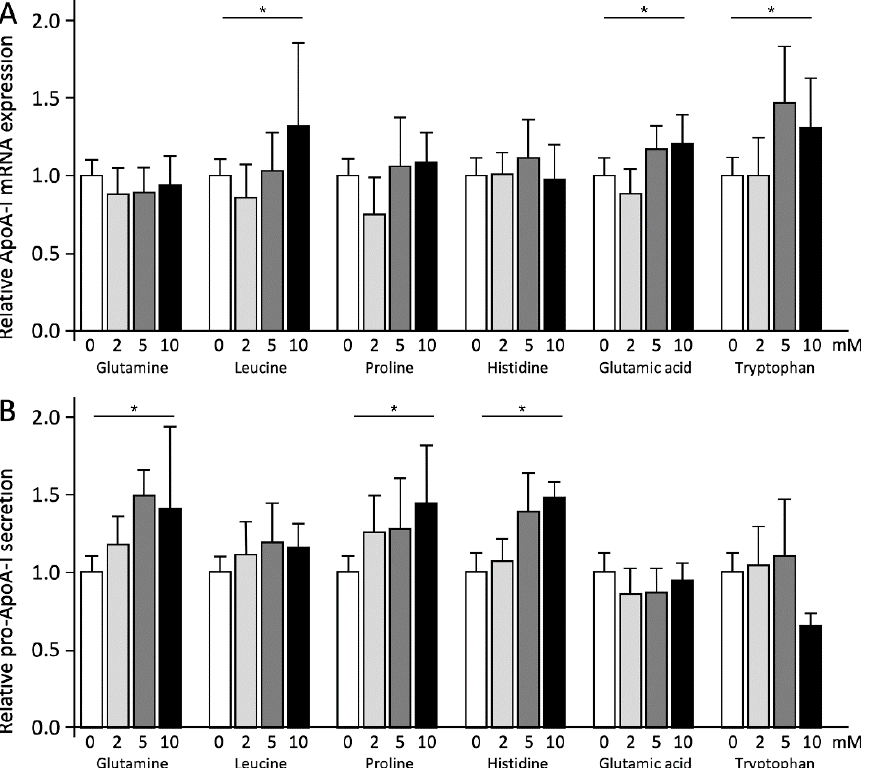
Figure 2. Amino acids have different effects on ApoA-I mRNA expression and pro-ApoA-I secretion. HepG2 cells were treated with 0–10 mM of six different amino acids for 48 h. ( A ) Relative ApoA-I mRNA expressions measured by qPCR. ( B ) Relative pro-ApoA-I protein secretions measured by ELISA. Results are presented as means with error bars indicating standard deviations. Data were normalized against the expression observed in the control condition, which was arbitrarily set at 1. amino acid treatment and controls were tested with linear regression analyses and were